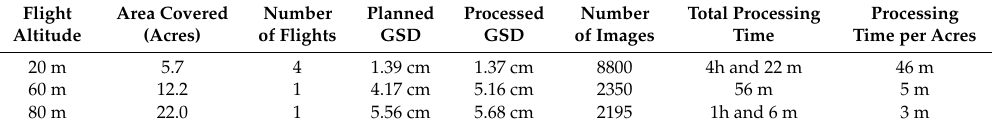
Table 3. Summary of flight parameters and details of collected images. GSD: ground sampling distance. Flight